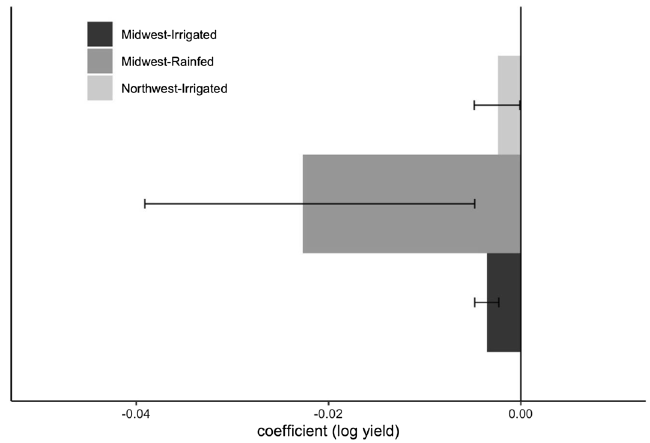
Figure 3. Regression coefficient estimates for the effects of extreme degree days (EDDs) by 1 degree day during anthesis on sweet corn yield (log scale) across the Midwest (Irrigated and Rainfed) and the Northwest (Irrigated) using commercial crop production data from 1992 to 2018. Extreme degree days were calculated using a base temperature of 30 ◦ C and no upper threshold for temperature. Error bars indicate bootstrapped 95% confidence interval using 1000